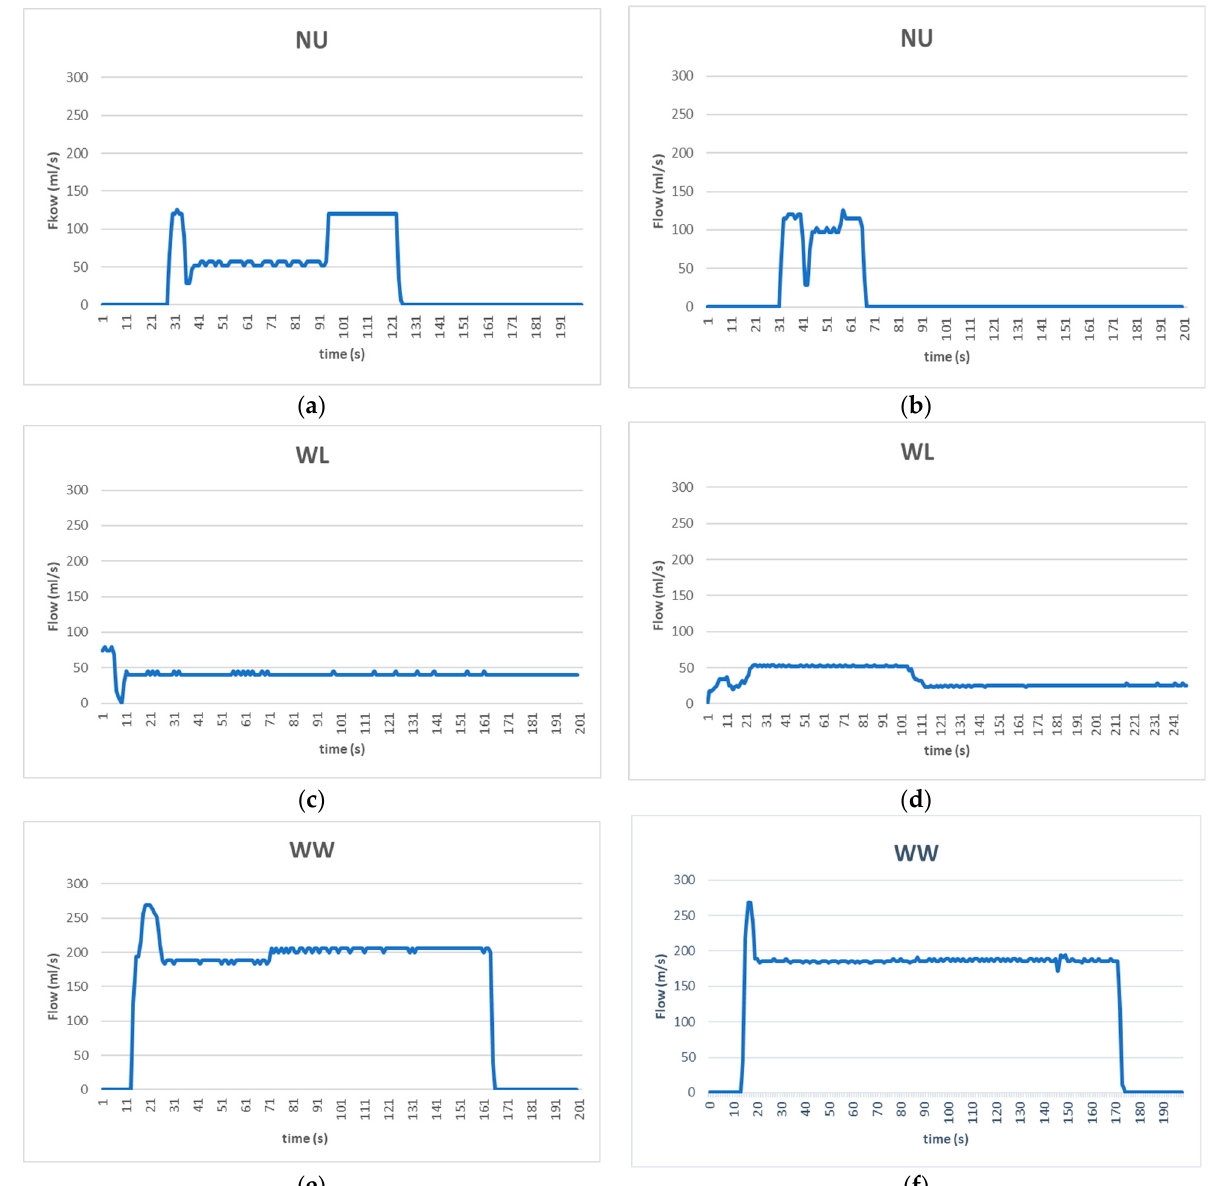
Figure 3. ( a , b ) Normal Use profiles; ( c , d ) Water Leak profiles; ( e , f ) Water Waste